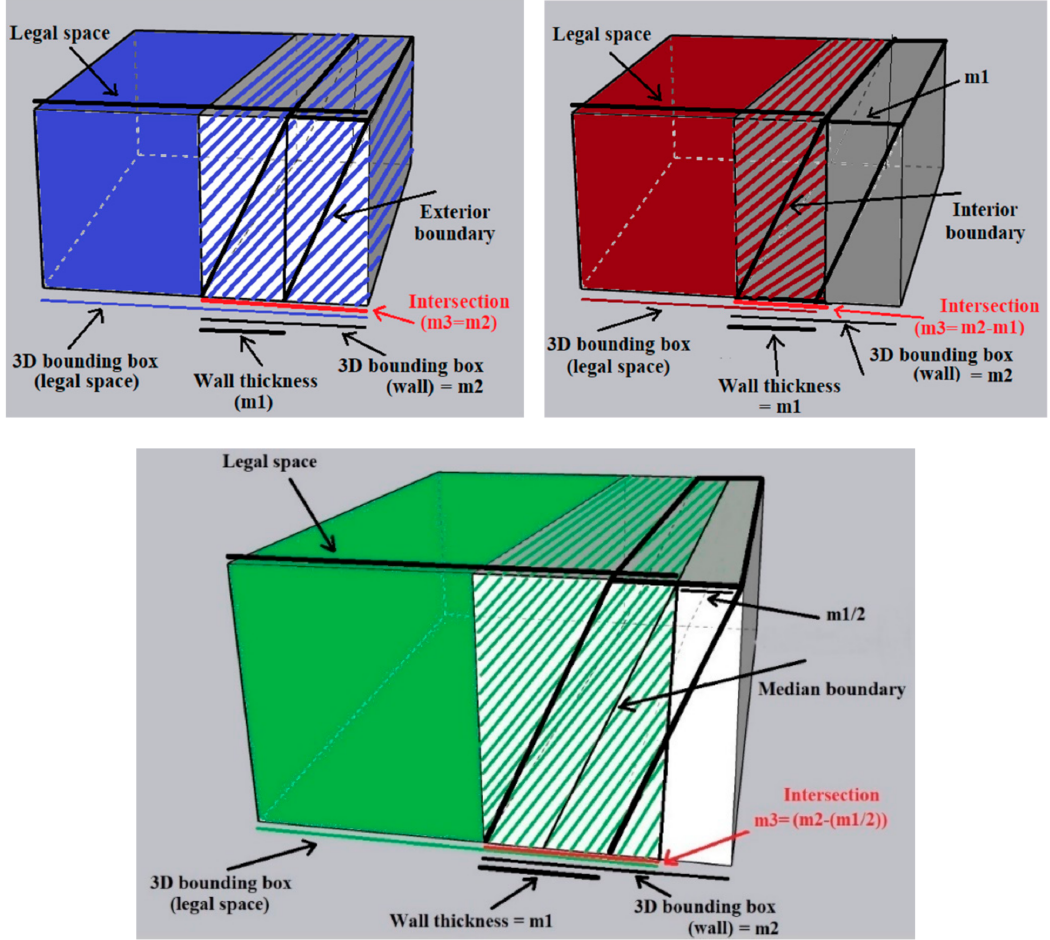
Figure 10. Using (thickness of intersection between 3D bounding box of the wall and 3D bounding box of legal space) as a criterion for differentiating among different types of property boundaries (an oblique wall).